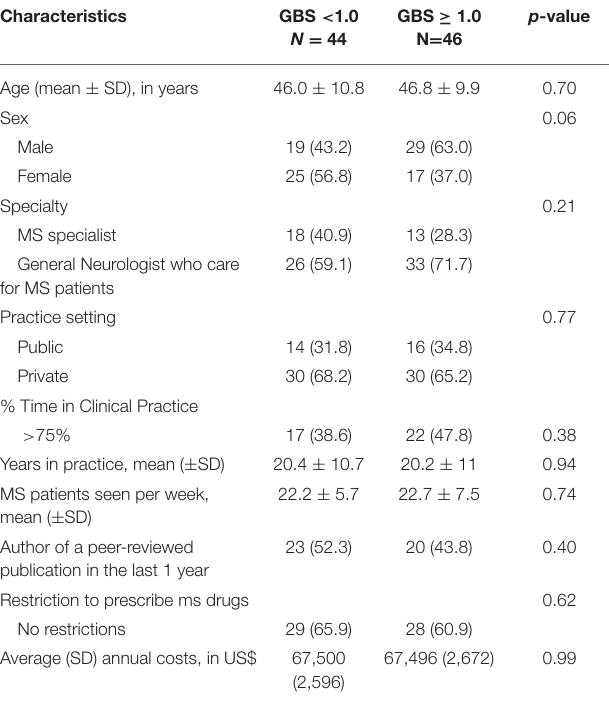
TABLE 1 | Baseline characteristics of